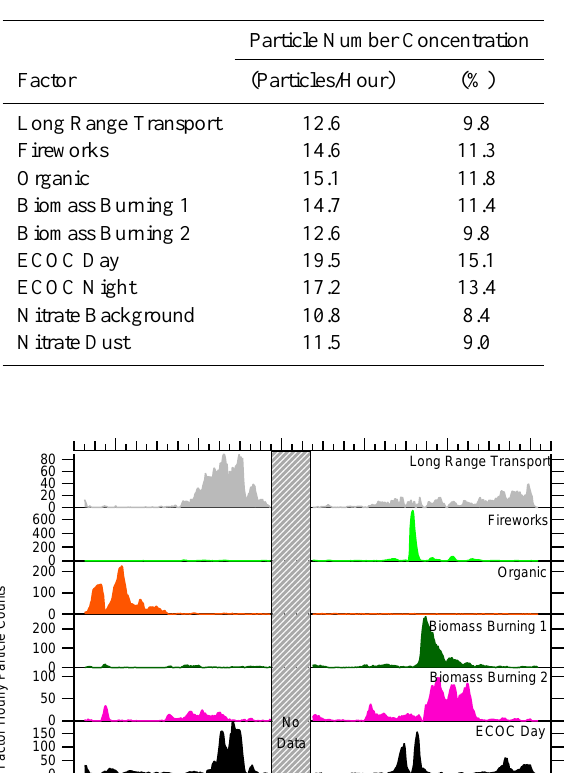
Table 2. Average factor contributions as measured by the ATOFMS and resolved by PMF during the BAQS-Met campaign.